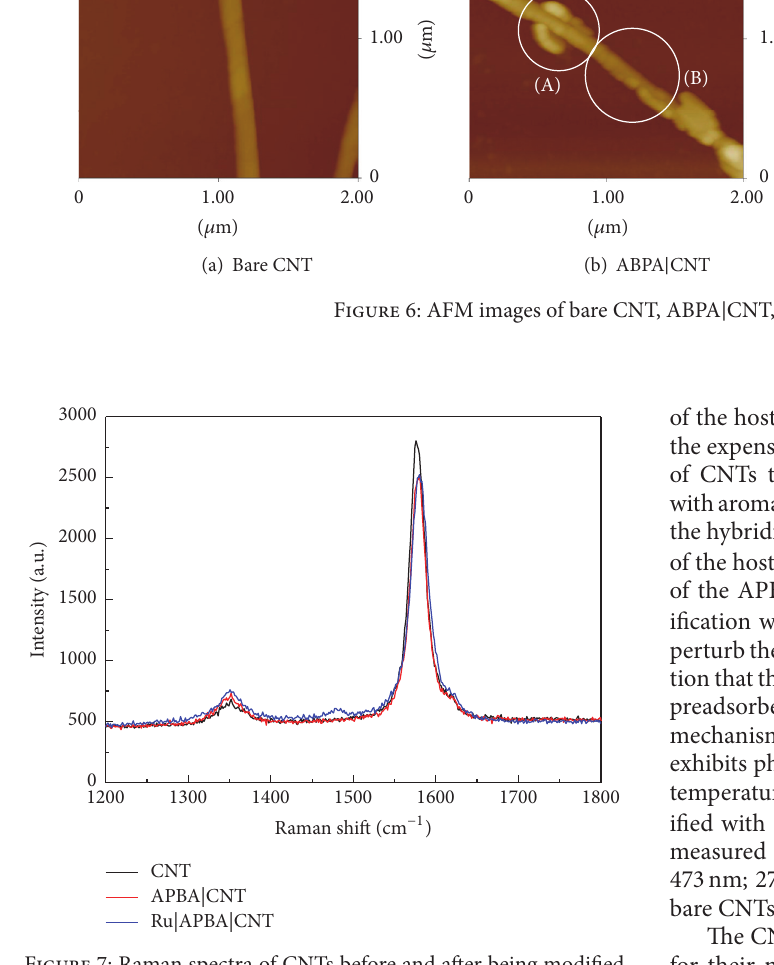
Figure 7: Raman spectra of CNTs before and after being modified with APBA and further with Ru(bpy) 2 (phendione) 2+